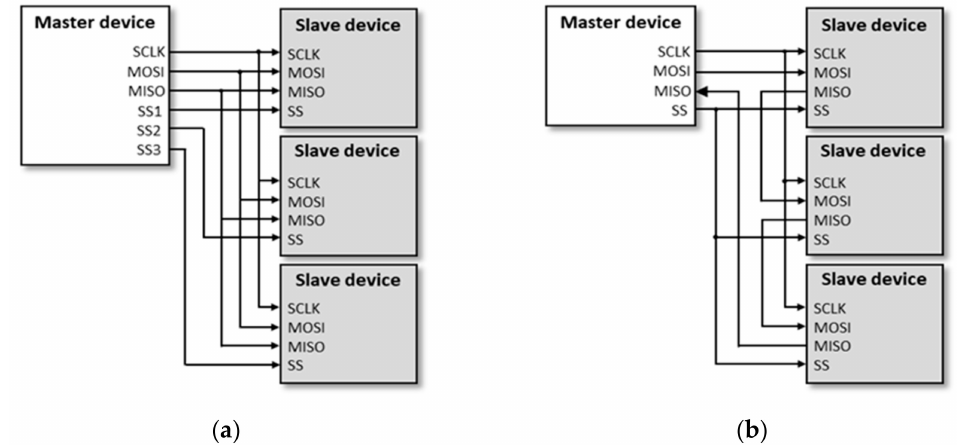
Figure 2. Multiple slave devices configuration diagram: ( a ) independent slave device configuration of SPI protocol block diagram and, ( b ) daisy chain slave device configuration of SPI protocol block diagram.